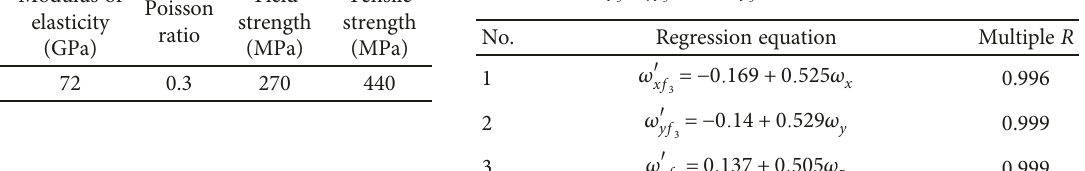
Table 13: Simulation results of empty storage tank and microsatellite.